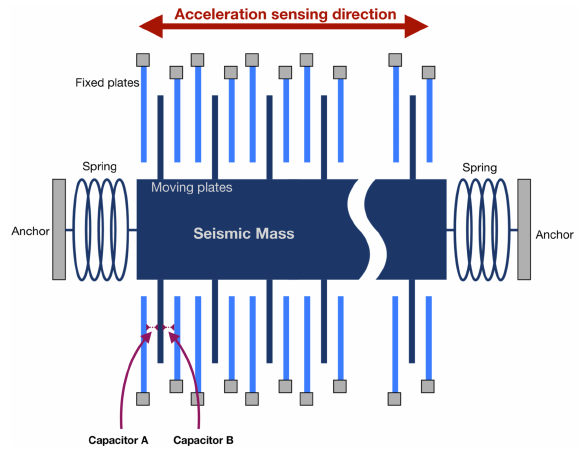
Figure 1. Working principle of a capacitive